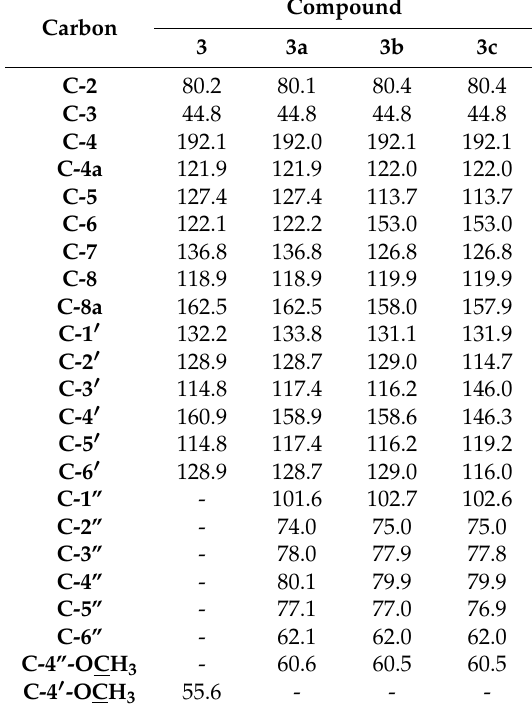
The 13 C-NMR shifts ( δ ) (ppm) of 4 (cid:48) -methoxyflavanone ( 3 ) and the products of